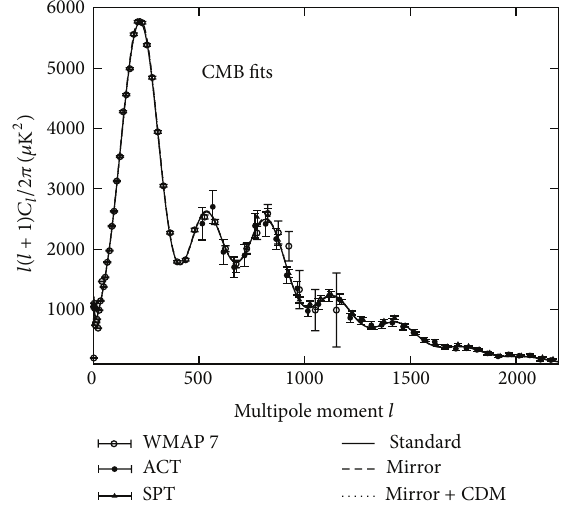
Figure 1: CMB power spectrum for best-fit models with baryons and mirror matter (dashed line), or baryons, mirror matter, and cold dark matter (dotted line) obtained using CMB only data. For comparison we show also the standard model fit (solid